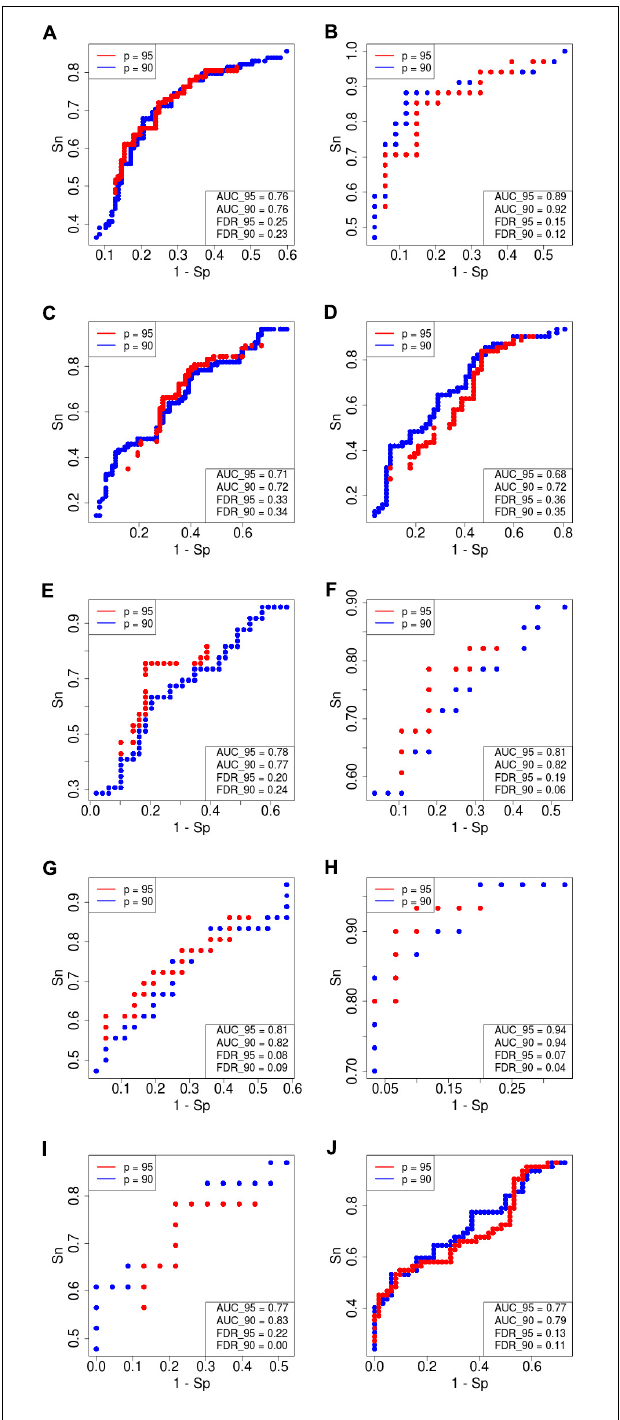
FIGURE 4 | Receiver–operator curves (ROC) showing the dependence of sensitivity ( Sn ) upon specificity ( Sp ) for FloWPS-based classifier of treatment response for datasets with core marker genes . Red dots: confidence parameter p = 0.95, blue dots: p = 0.90. Panels represent different clinically annotated datasets, (A) GSE25066; (B) GSE41998; (C) GSE9782; (D) GSE39754; (E) GSE68871; (F) GSE55134; (G) TARGET-50; (H) TARGET-10; (I,J) TARGET-20 with and without busulfan and cyclophosphamide,